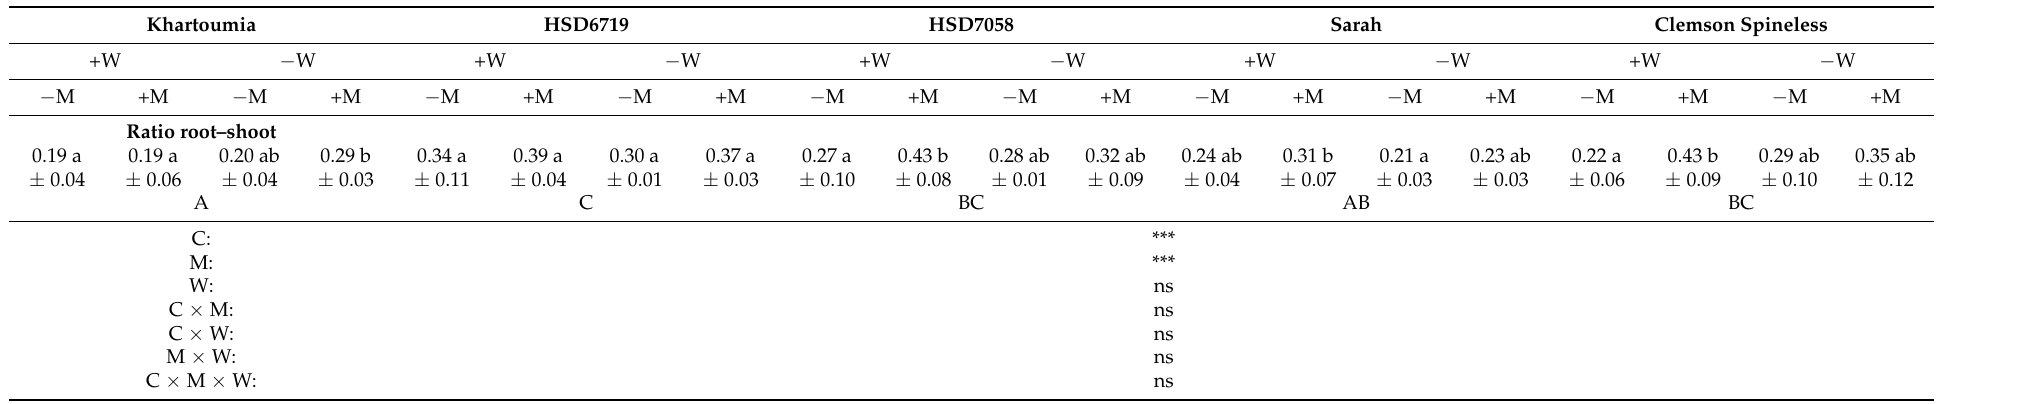
Table 1. Ratio of root–shoot (based on DW) of the five okra cultivars. Plants were non-inoculated ( − M) or inoculated (+M) with R. irregulare . Substrate water content was either maintained at 20% (+W) or 10% w / w ( − W). For definitions of treatments and statistics, refer to the text for Figure 3. Shown are mean values ± standard deviation. Within each cultivar mean values followed by the same small letter are not significantly different (Tukey’s test, n = 4, p < 0.05). Cultivars followed by the same capital letter are not significantly different (Tukey’s test, n = 4, p <